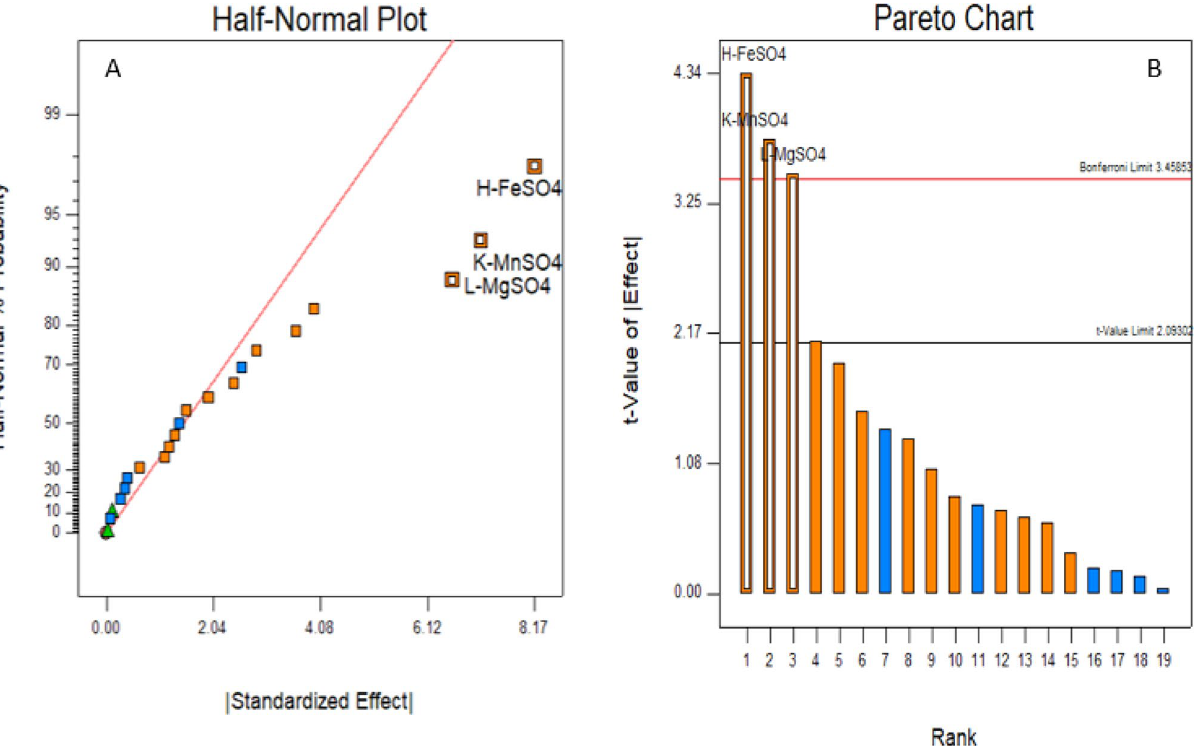
Figure 2. ( A ) Half-normal plot; ( B ) Pareto chart showing the effects of different